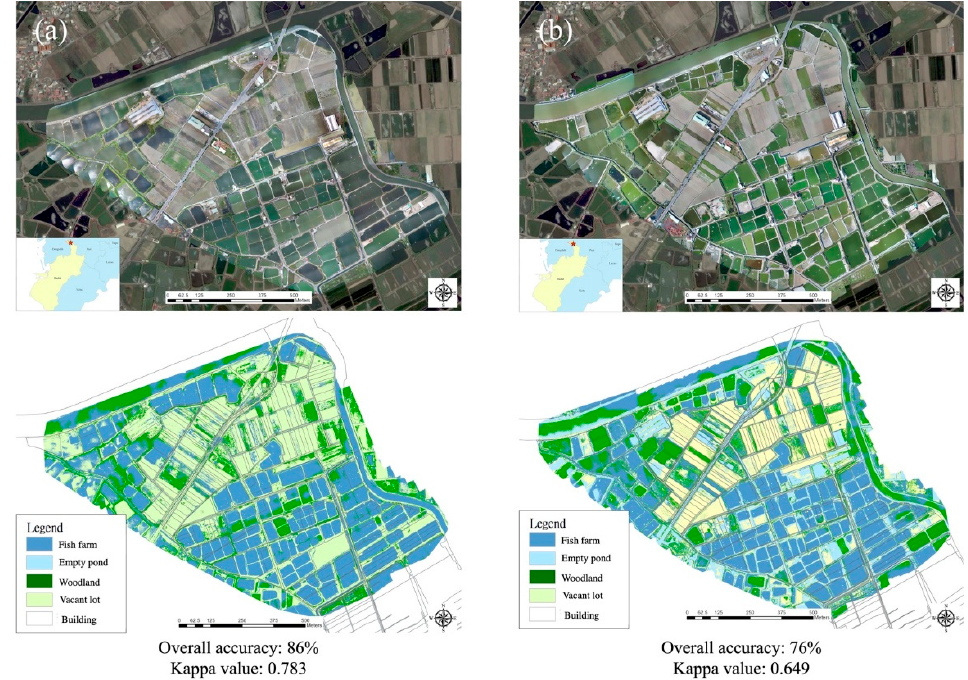
Figure6. InterpretationaccuracyattheBudaisamplingsite. Theorthophotocapturedon( a )6September2018; Figure 6. Interpretation accuracy at the Budai sampling site. The orthophoto captured on ( a ) 6 ( b ) 15 October 2018. September 2018; ( b ) 15 October 2018. Table 5. Accuracy assessment results for three image composites at the Budai sampling site. Image